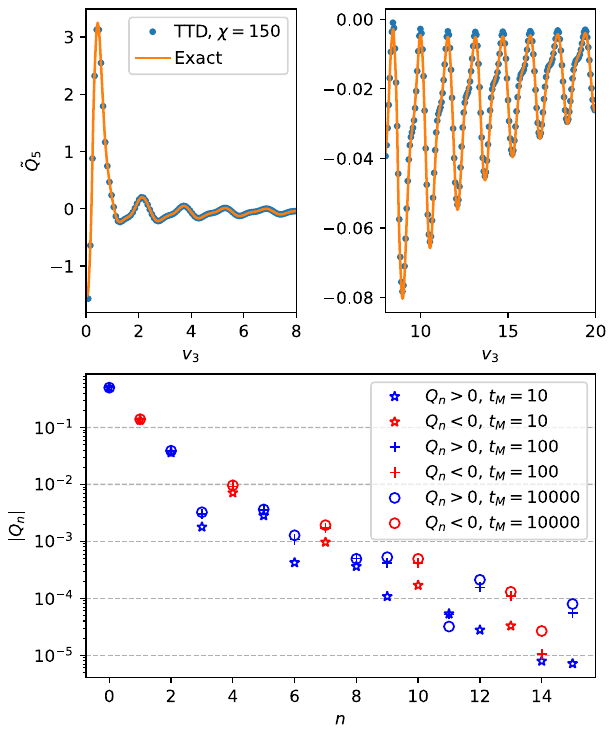
FIG. 16. One interacting site in an infinite two-dimensional ˜ Q 5 ð v 1 ; v 2 ; v 3 ; v 4 ; v 5 Þ versus v 3 for a lattice. Upper: integrand random choice of the values v 1 , v 2 , v 4 , and v 5 . The right panel enlarges the tail. Actual integrand (orange curve) and TTD approximation at χ ¼ 150 (blue circles) are both shown. Lower: FIG. 17. Three different factorizations used for the double j Q n j versus n for three values of the maximum time, t M ¼ 10 100 (pluses), and t 10000 (circles). Blue (red) (stars), t quantum dot problem. From top to bottom: vertex factorization, M ¼ M ¼ time factorization, and full symbols correspond to positive (negative) values of Q . n